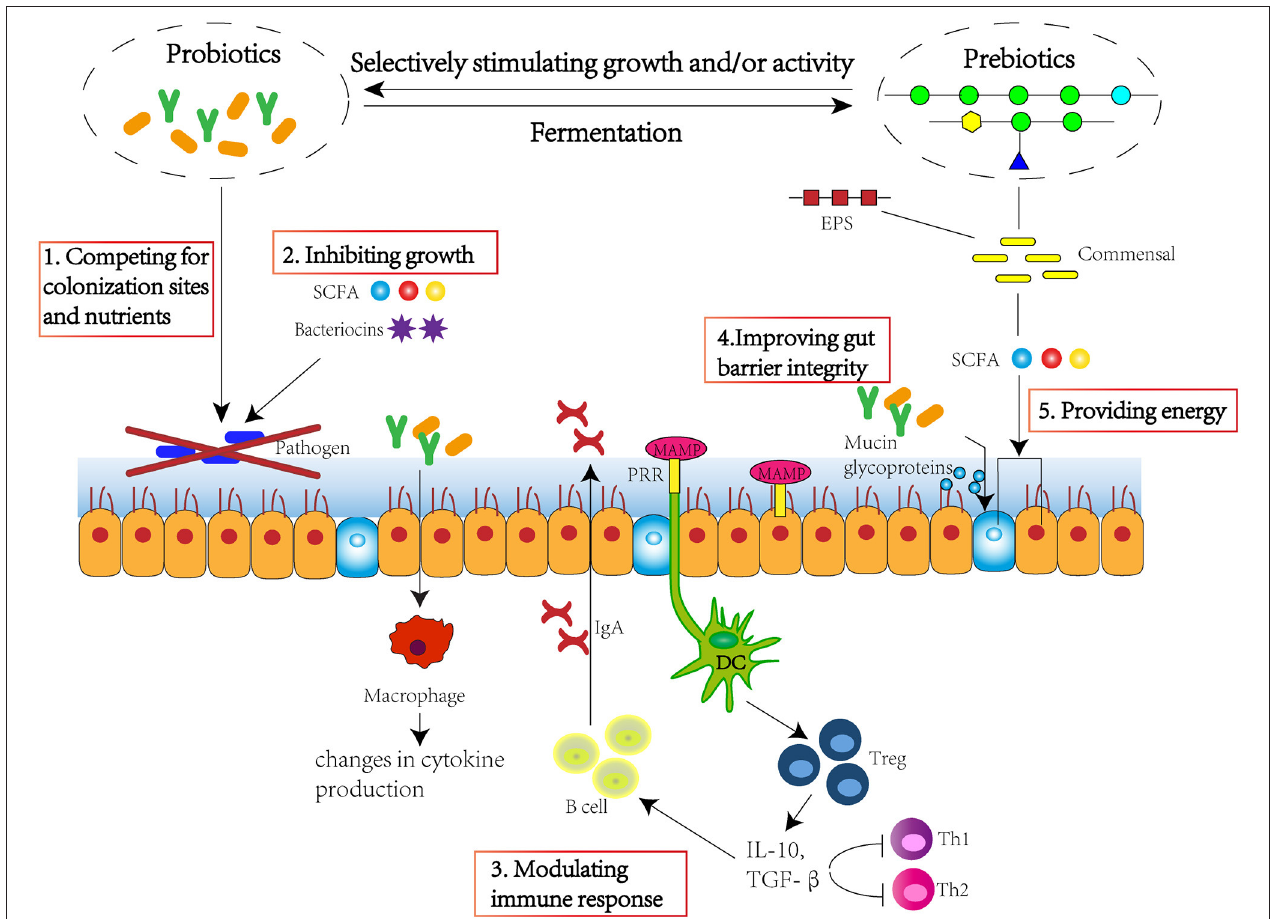
FIGURE 1 | Pre-biotics, probiotics, and post-biotics are able to improve intestinal microbiota homeostasis, maintain gut barrier integrity, and modulate immune response. The approach mechanisms include 1. competing for colonisation sites and nutrients; 2. inhibiting growth through production of SCFA and bacteriocins; 3. modulating immune response through stimulating immune cells and cytokine and immunoglobulin production; 4. improving gut barrier integrity through stimulating the production of mucin glycoproteins; 5. providing energy for epithelium, improving villi growth, crypt development, tight junctions, and mucin production. SCFA, short-chain fatty acid; EPS, exopolysaccharide; MAMP, microorganism-associated molecular patterns; PRR, pattern recognition receptor; DC, dendritic cell; Treg, regulatory T cell; IL-10, interleukin 10; TGF- β , transforming growth factor β